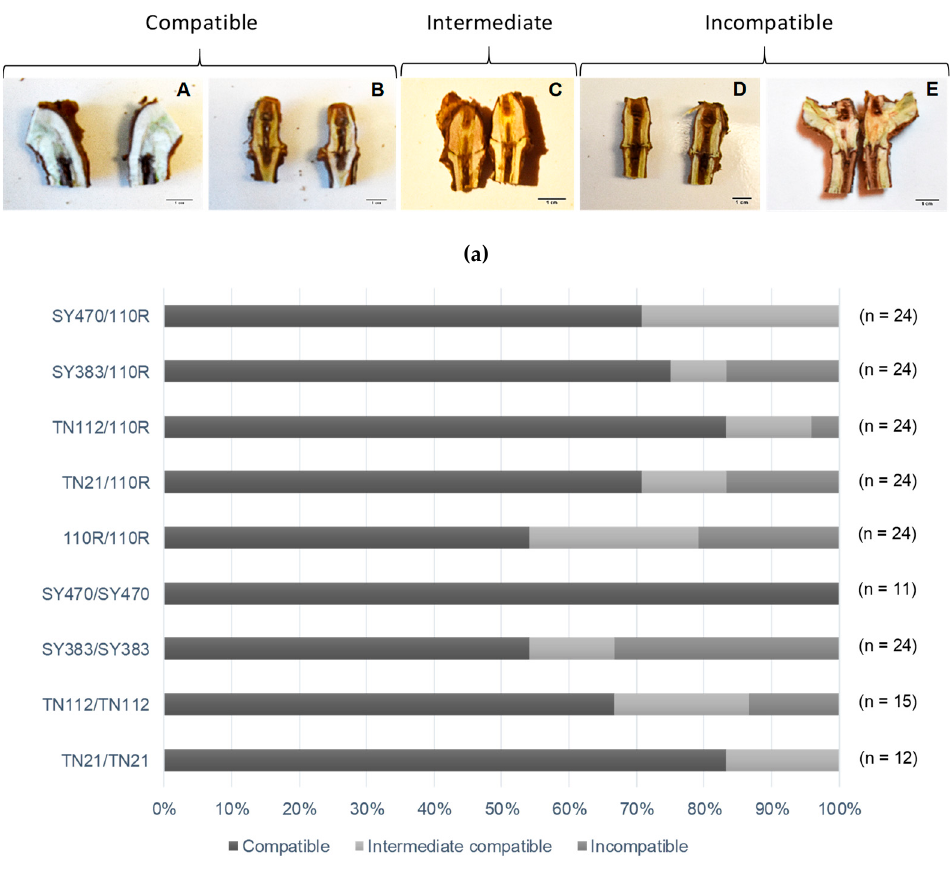
Figure 2. Internal characterization of the graft union. ( a ) Example images of the category A to E charactering the internal graft unions. Category A represents a perfect union in which the graft line is almost invisible. Category B shows few structural imperfections and / or slight discontinuities between wood and bark or cambial invaginations. Category C is characterized by bark discontinuities and D by wood discontinuities. Category E includes broken / unattached unions and / or unions with dead tissue in proximity of the union line. ( b ) Proportion (%) of compatible, intermediate, and incompatible classes detected per graft combination.